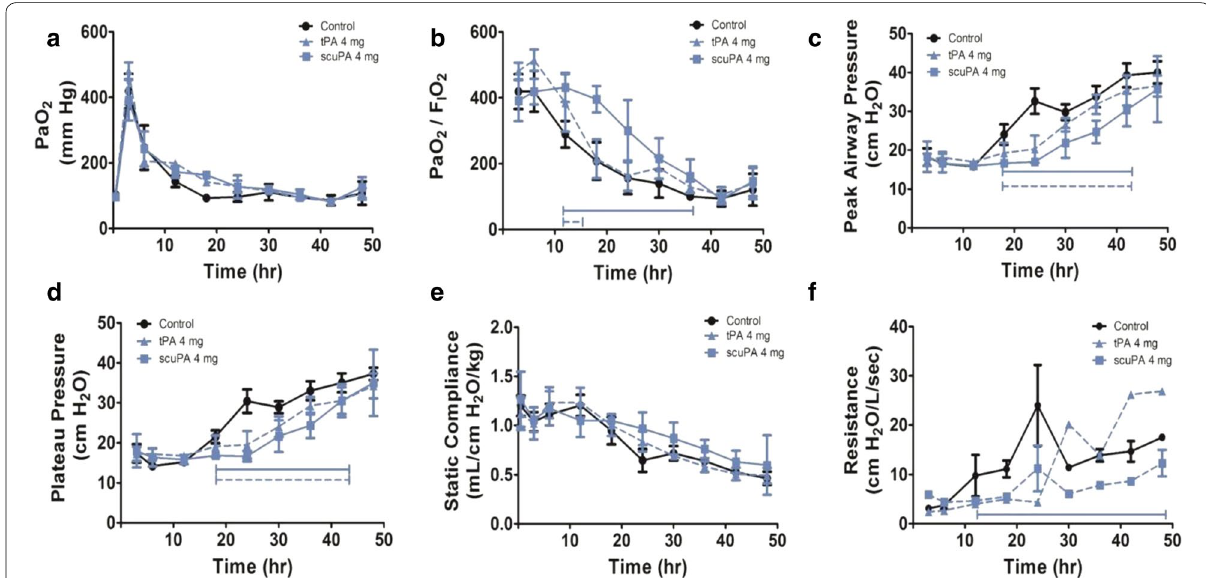
Fig. 2 Group 1 pathophysiologic changes during the progression of ISIALI. Data from saline vehicle nebulized controls (n 5, including one animal = that died prematurely; before 48 h in the control vehicle group) or animals nebulized with tPA (n 4) or scuPA (n 3) in Group I at the 4 mg/ = = unit dose are illustrated in a – f and plotted as line graphs with means and standard errors of the means. Nebulized plasminogen activators at the indicated doses were delivered according to the schedule illustrated in Fig. 1. a PaO 2 : arterial oxygen tension (mmHg): no significant difference between treatment groups over time. b PaO 2 /FiO 2 ratios: statistically significant increase of scuPA (p 0.02) and tPA (p < 0.001), compared to control. = c , d Peak and plateau airway pressures (cmH 2 O): statistically significant decrement in tPA and scuPA treated groups compared to control (p < 0.001); scuPA treated was less than tPA (p 0.03), independent of time. e Static lung compliance (mL/cmH 2 O/kg): no statistically significant difference = between treatment groups as well as with control; f lung resistance (L/cmH 2 O/min): was significantly reduced in the scuPA 4 mg group (p 0.045) = but not in the tPA group. All depicted trends were statistically significant over time (p < 0.001). Statistical significance of treatment groups against controls over time is shown by solid (scuPA) or dashed (tPA)